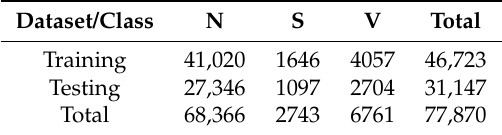
Table 2. Number of beats per beat-class and datasets.